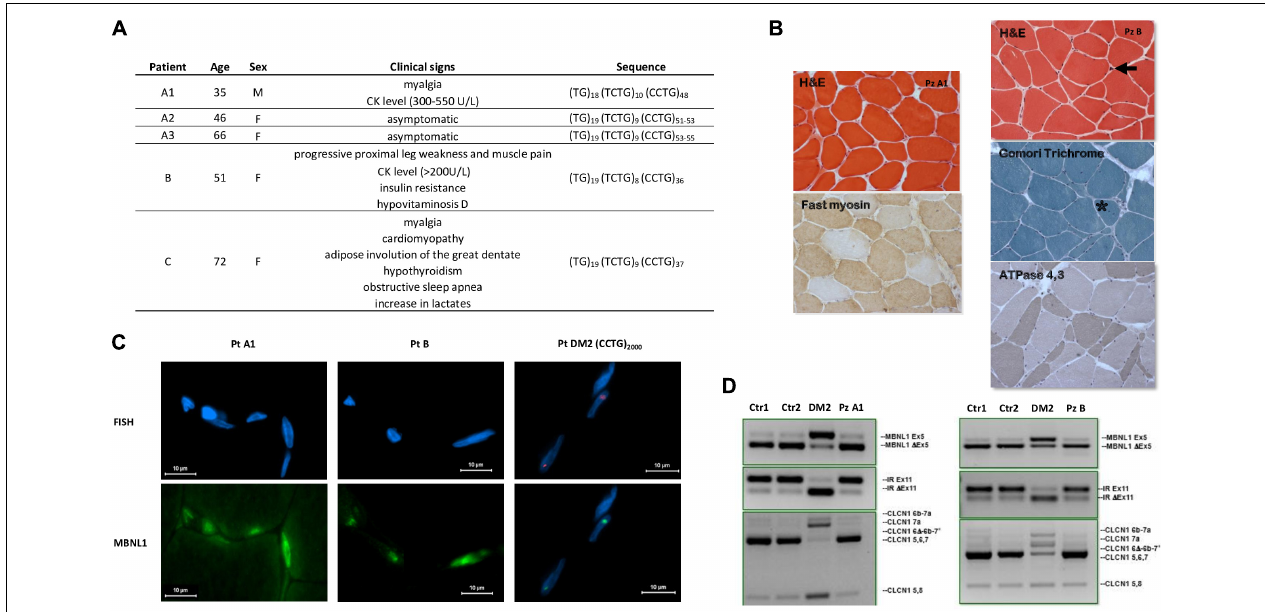
FIGURE 5 | Patients with CNBP premutated alleles. (A) Clinical characteristics of DM2 premutated patients and sequence of the uninterrupted CNBP alleles. (B) Left: Patient A1, Biceps brachii muscle biopsy performed at the age of 16 shows only a slight fiber size variability both of type I and II fibers (200 × ). Right: Patient B, Biceps brachii muscle biopsy performed at the age of 51 shows an increase of fiber size variability, nuclear clumps (arrow), central nuclei (asterisk) and type I (200 × ). (C) FISH + MBNL1 immunofluorescence of patient A1 and B shows no nuclear accumulation of CNBP mutant RNA or of MBNL1 as instead observable in a DM2 patient with (CCTG) 2000 repetitions. (D) Similarly to healthy individuals (Ctr1 and Ctr2), no alterations of alternative splicing of MBNL1 , IR , and CLCN1 genes have been evidenced by RT-PCR analysis compared with a DM2 patient, used as positive